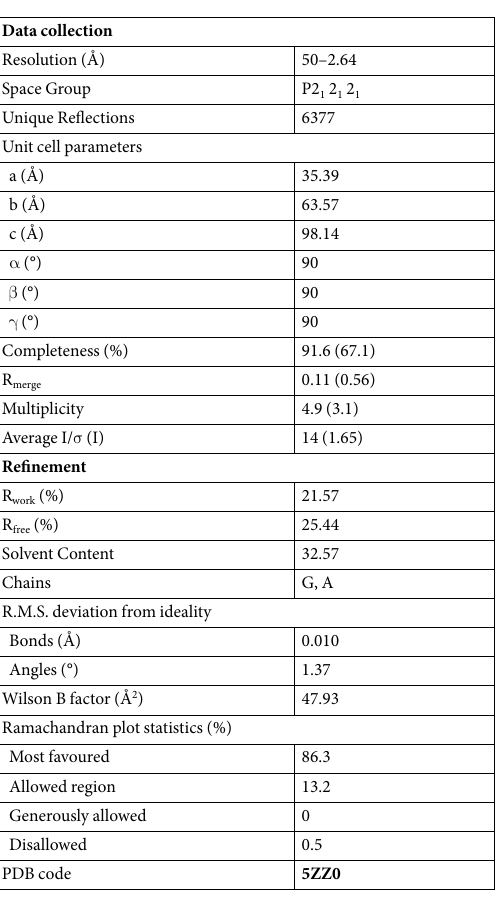
Table 2. Data collection statistics from the crystal of fragment 28–161 in presence of Ca 2 + and at low pH are tabulated here. Values in the parentheses refer to the highest resolution